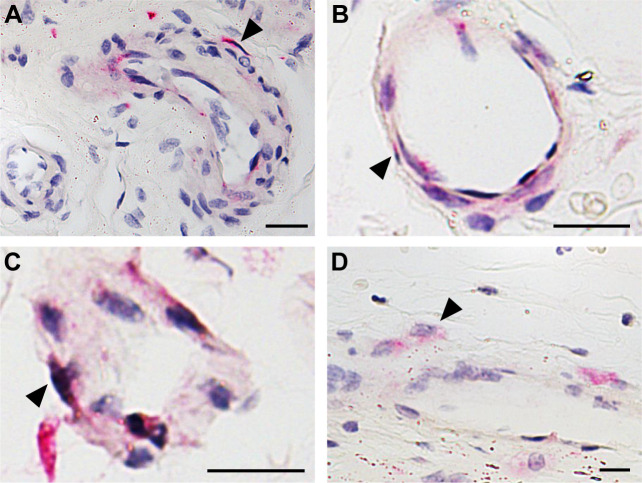
Perivascular CD107a immunohistochemical staining in diverse human adipose tissues.(A) Visceral pericardial fat, (B) visceral perigonadal fat, (C) visceral perirenal fat, and (D) omental fat. CD107a positive staining appears red (black arrowheads). N = 3 human samples per tissue depot examined. Black scale bar: 20 μm.